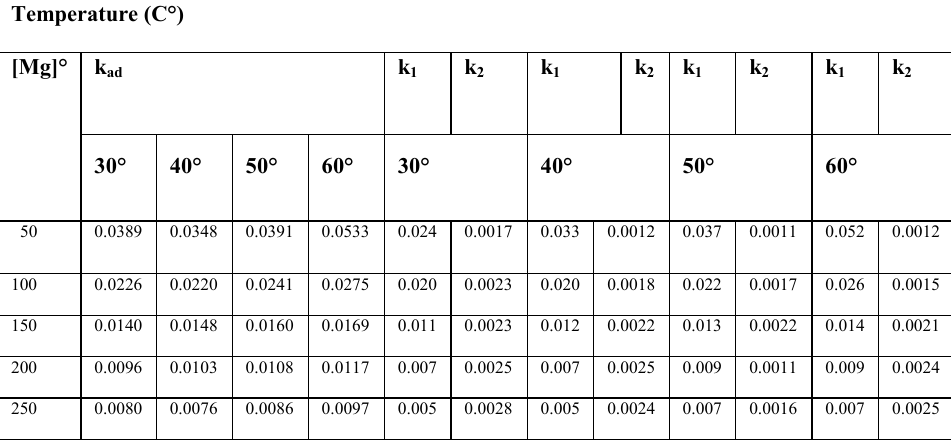
Table 5. Rate constants for the adsorption of malachite green dyes (k